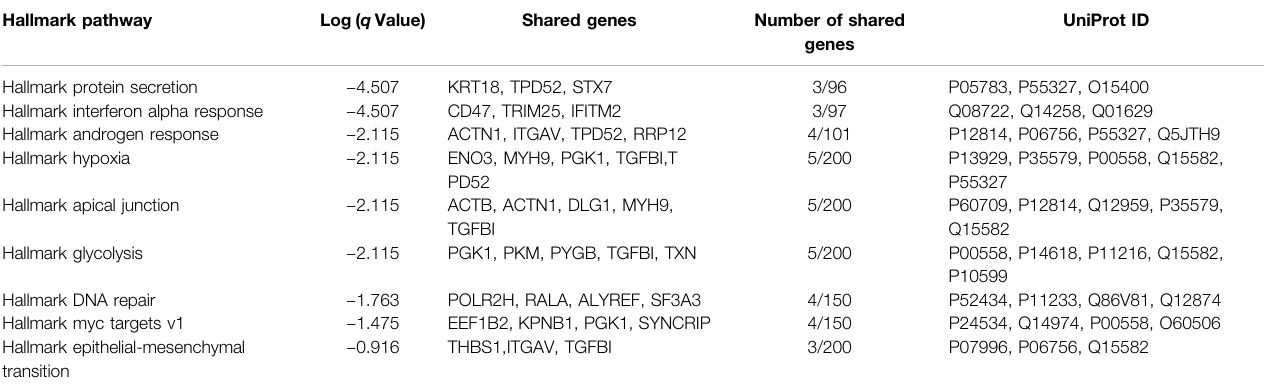
TABLE 2 | Hallmark pathways identi fi ed using Metascape (Metascape.com) for differentially expressed proteins between control and TGF- β -treated ATII ER:KRASV12 cells. Hallmark